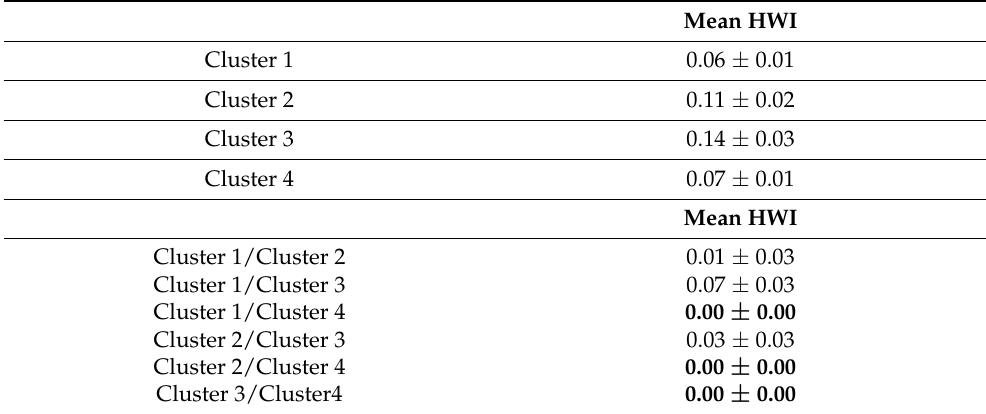
Figure 6. The dendrogram of the agglomerative hierarchical cluster analysis performed to identify different degrees of association of 48 bottlenose dolphins re-sighted at least three times in the Gulf of Taranto. The letter ‘F’ indicates the individuals sexed as females. Cluster 1 is shown in purple, cluster 2 in red, cluster 3 in green and cluster 4 in light blue. Table 4. Mean values of half-weight association index within and between clusters. Null values of half-weight association index were reported in bold.